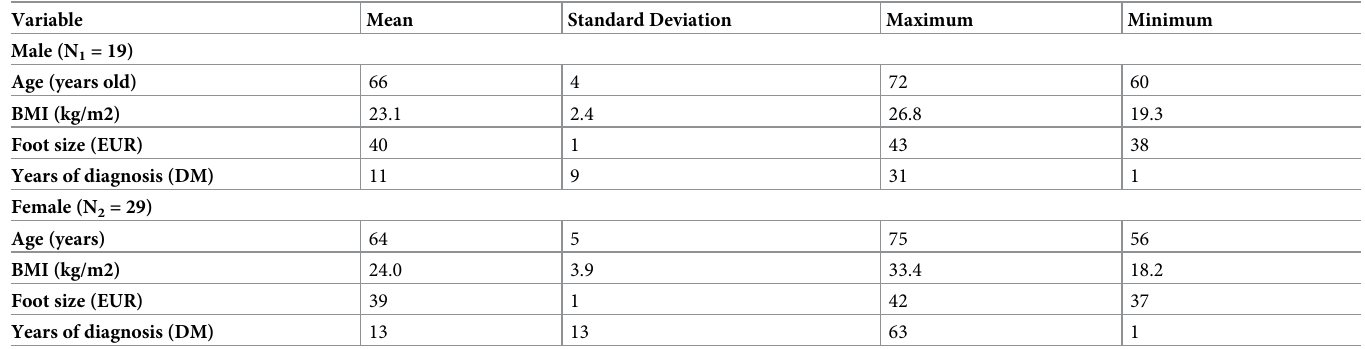
Table 1. Descriptive statistics of participants (n =